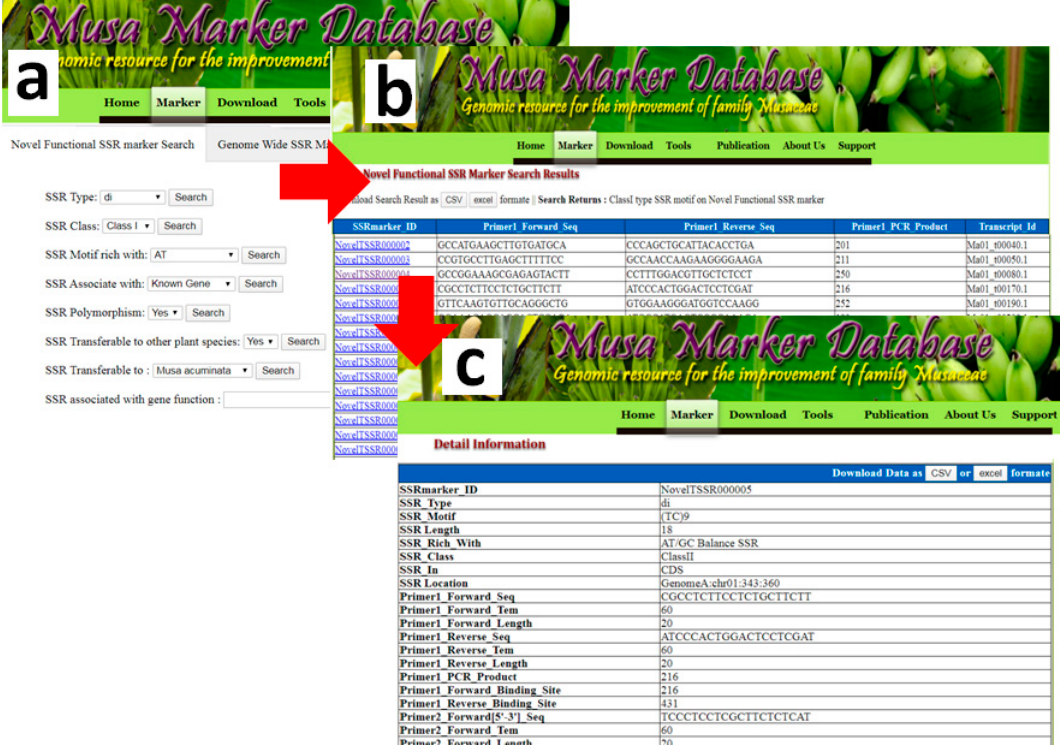
Figure 5. The flow of a database search in NFMS. ( a ) marker search interface ( b ) query result ( c ) details information of each marker.